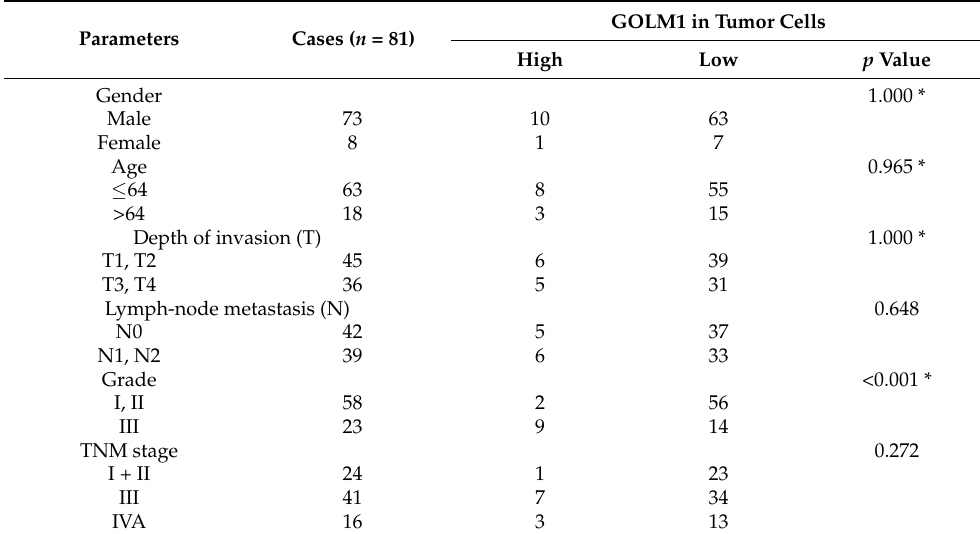
Figure 6. CK, GOLM1, FAM49B, CD3, CD20, and CD68 proteins were detected by mIF in the HNSCC tissues. ( A ): CK; ( B ): GOLM1; ( C ): FAM49B; ( D ): CD3; ( E ): CD20; ( F ): CD68; ( G ): Co-expression of CK, GOLM1, and FAM49B (green arrow showed). ( H ): Co-expression of GOLM1 and CD3 (yellow arrow). ( I ): Co-expression of FAM49B and CD3 (red arrow). ( J ): Co-expression of GOLM1 and CD68 (green arrow), the red signal is VISTA, and the pink signal is CD68. ( K ): Co-expression of FAM49B and CD68 (green arrow). ( L ): Merged images of all markers. ( M ): CD3; ( N ): FAM49B; ( O ): Co-expression of FAM49B and CD20 (green arrow). ( P ): Merged images of all markers. (Original magnification ( A – L ) × 200, ( M – P ) × 400). Table 2. High expression of GOLM1 protein was associated with clinicopathological parameters of HNSCC